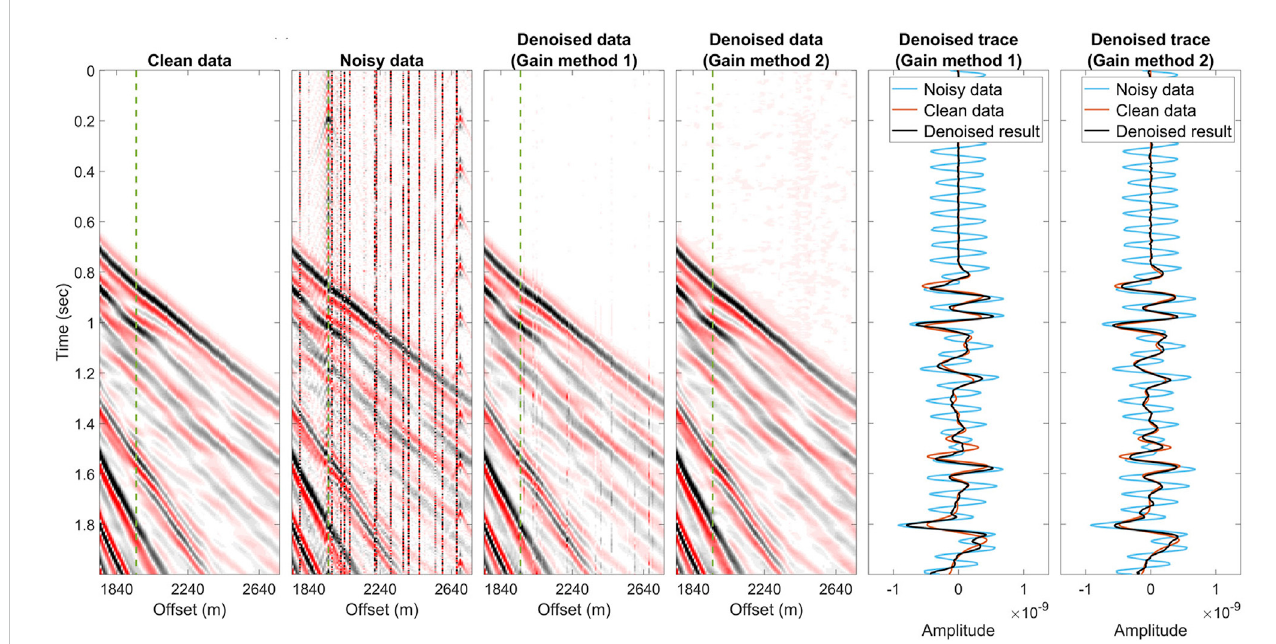
FIGURE 6 Zoomedimagesofthesyntheticdatapairandthedenoisedresults.Thetracesnotedasgreenlinesinpanelsareusedtocomparedenoisedresultsgainedby the AGC (method 1) and the proposed 2D AGC (method 2). The trained network using no matter the AGC or the 2D AGC for energy recovery can suppress the strong oscillation noise. However, the denoised result pre-processed by the AGC method has uneven amplitude change that does not exist in the clean data.